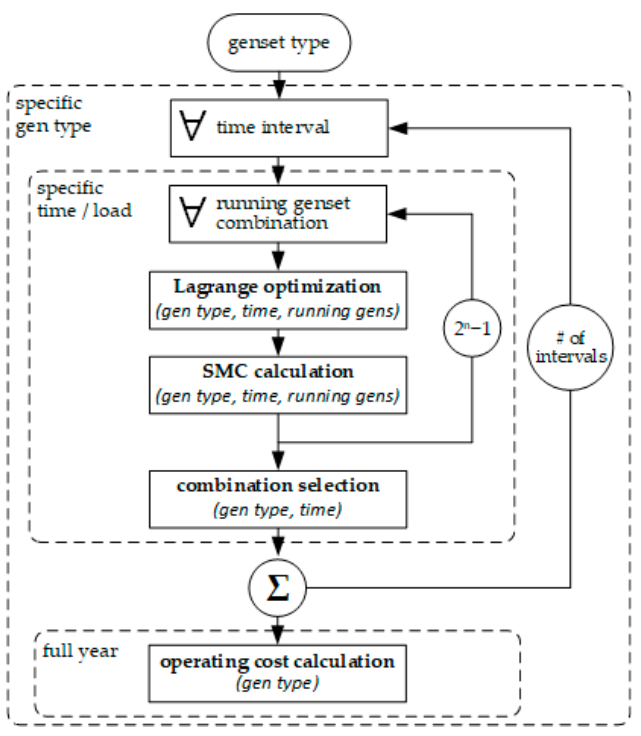
Figure 4. Operating cost calculation process. If all the engines populating the power plant have identical behavior, the optimiza- tion process may be simplified using equal distribution. However, the algorithm uses optimization to address different duty cycles of the gensets and any future expansion of this